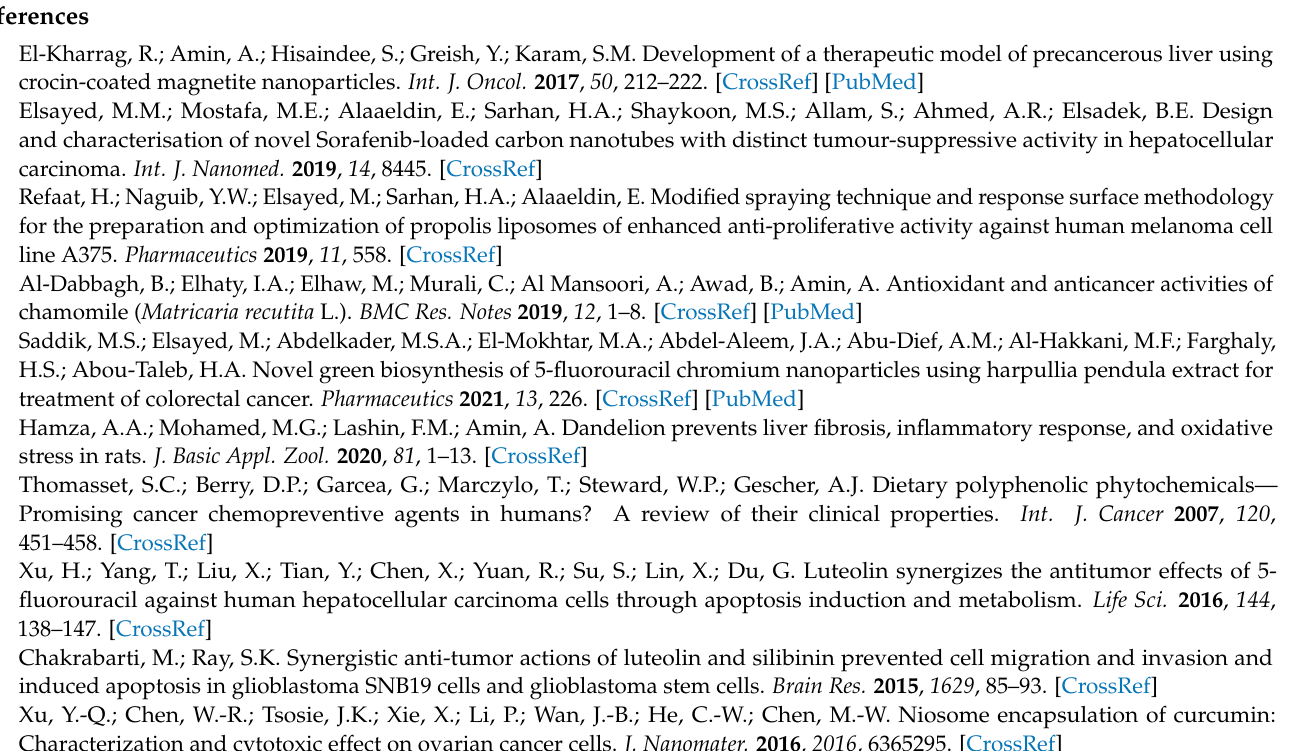
n = 3), Figure S2: Vesicle size of the selected LUT loaded ethosomal formulation (F8), Figure S3. Zeta potential of the selected ethosomal formulation (F8), Table S1: The accuracy of the used spectrophoto- metric procedure, Table S2: The intraday and interday precision profile, and Table S3: The calculated correlation coefficient for the in vitro release of LUT from the prepared